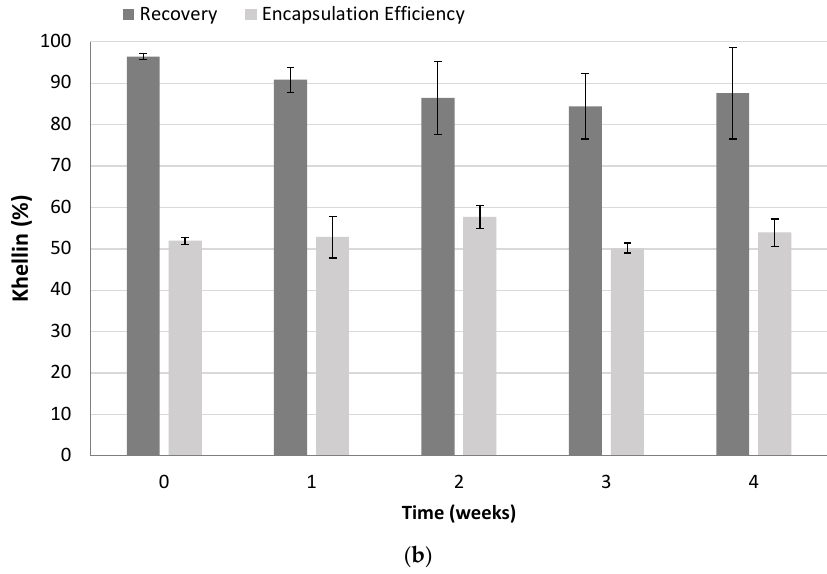
Figure 7. Shelf life of freeze-dried K-NLCs in terms of: ( a ) size, PdI and ζ -potential; ( b ) recovery and encapsulation efficiency of khellin. Data are shown as the mean ± standard deviation ( n = 3).